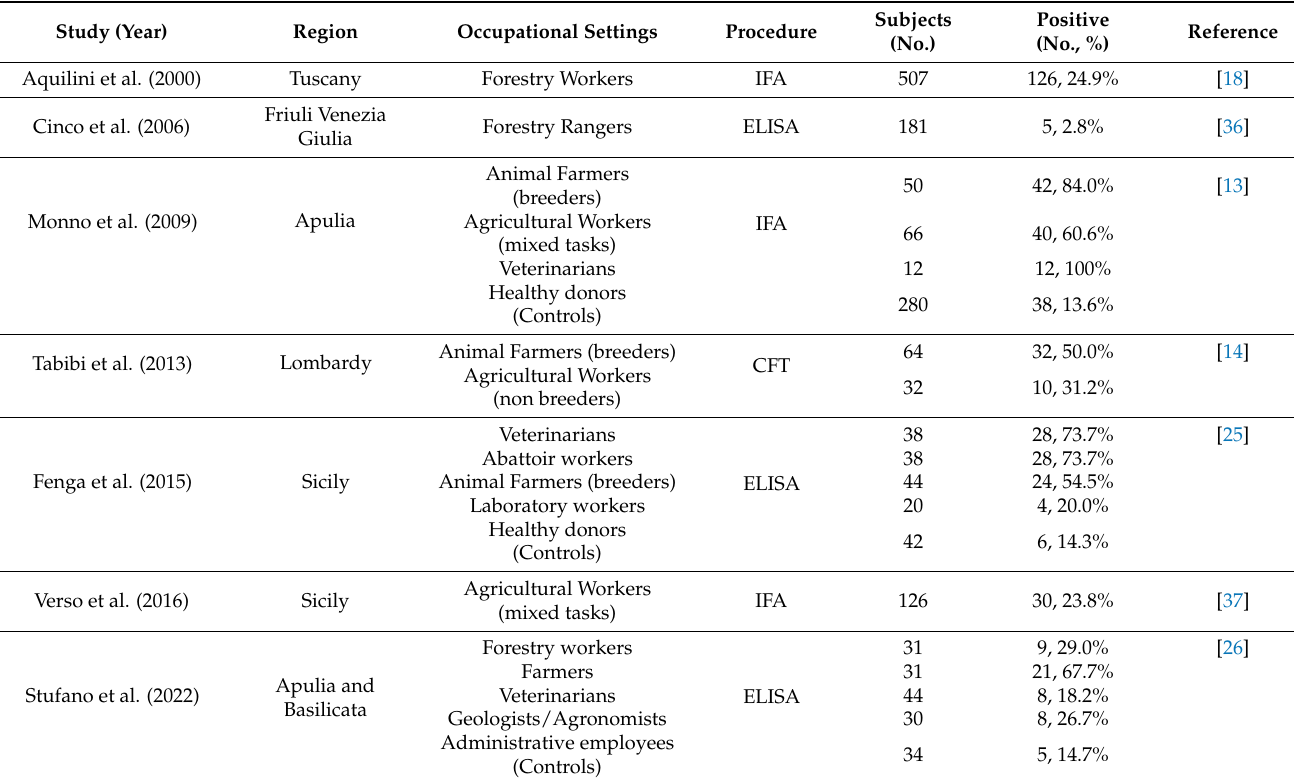
Table 2. Summary of retrieved seroprevalence studies for Q Fever in Italy, occupational settings.